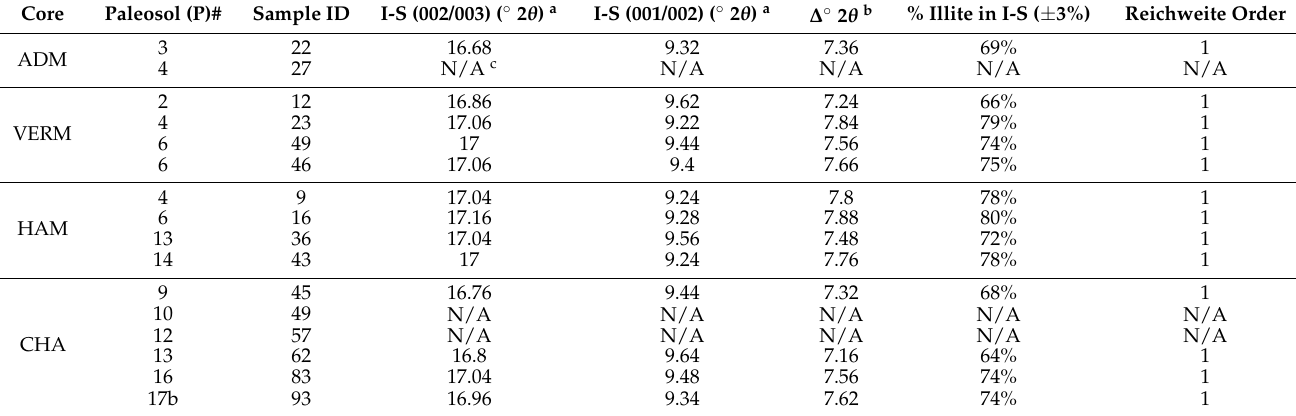
Table 3. Results of XRD analysis of the <0.2 µ m clay-sized fraction of Illinois Basin paleosol